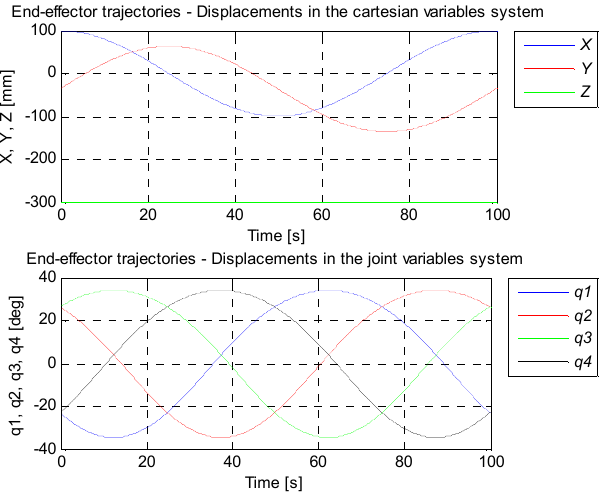
Figure 17. The course of Cartesian ( top ) and configurational ( bottom ) variables for the given track.